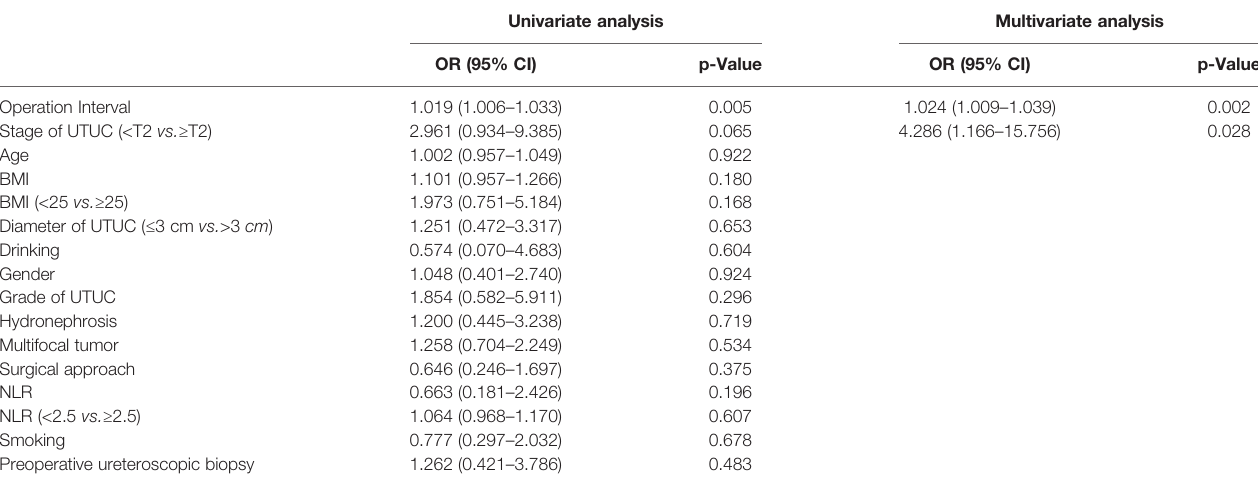
TABLE 5 | Univariate and multivariate analyses for factors associated with BC greater than 3 cm after RNU.